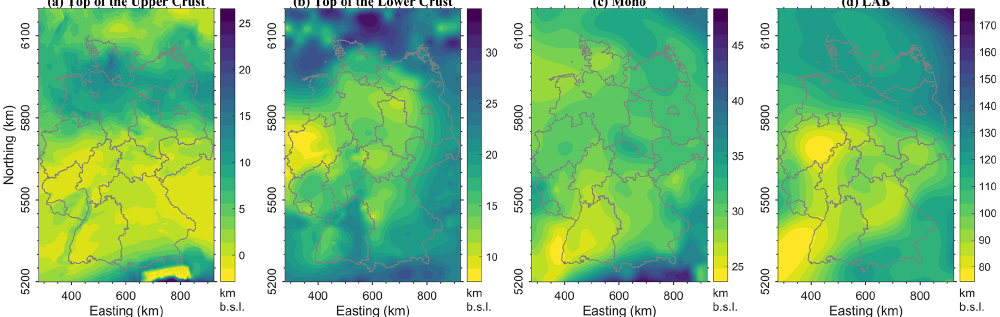
Figure 3. Thicknesses of the major structural layers of the 3-D-D model: (a) Cenozoic; (b) Mesozoic; (c) Zechstein; (d) Permo- Carboniferous; (e) Pre-Permian; (f) Upper Crust; (g) Lower Crust; (h) Lithospheric Mantle. Colour bars show thickness in km .